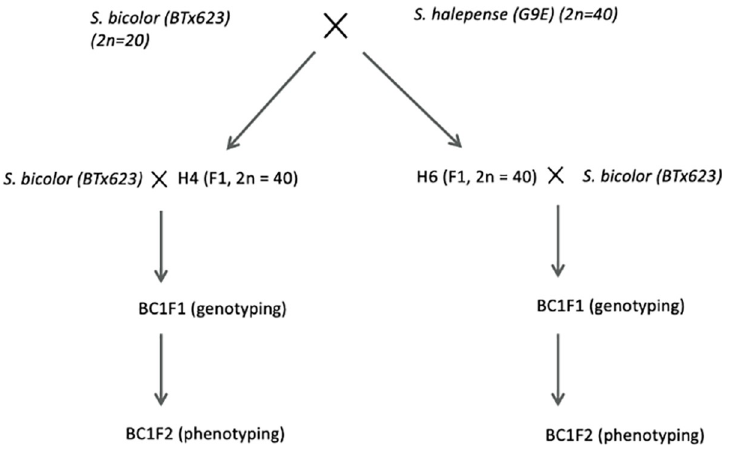
Fig 1. Population development of the two